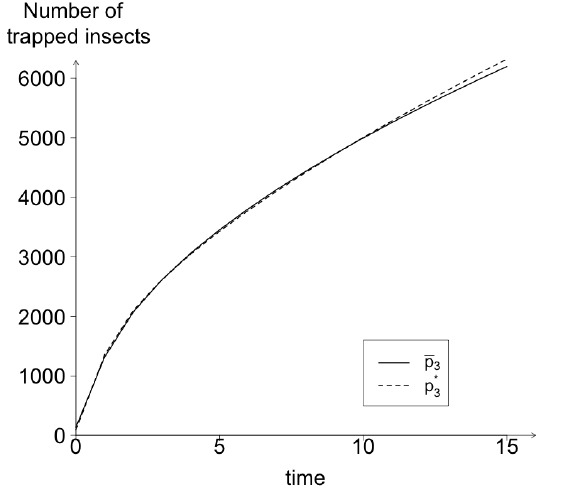
Fig. 6. Simulated cumulative number of captures when estimating three parameters with setting (A), using the real values, ¯ p 3 , and the identified values, p ∗ 3